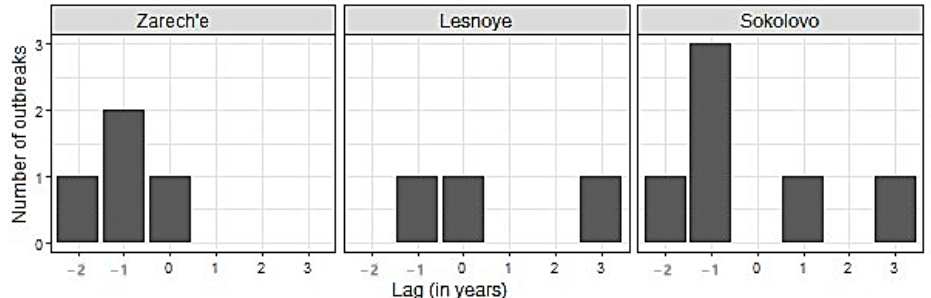
Figure 7. The lag between recorded and reconstructed defoliation periods.